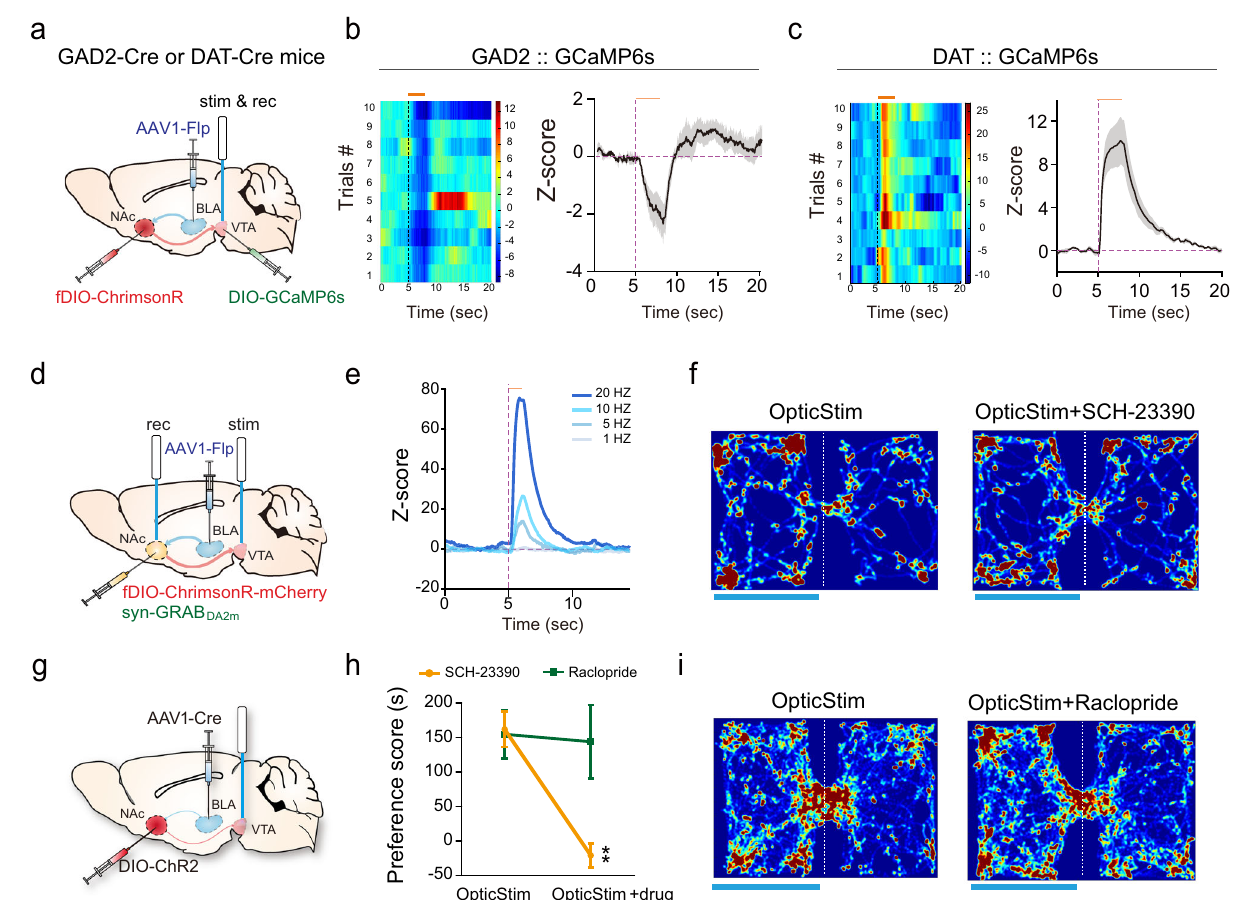
Fig. 5 | NAc BLA neuronsmediate reward by disinhibiting dopaminergic neurons in the VTA. a Schematic showing the experimental design to record Ca 2+ signal from GABAergic or dopaminergic neuronal populations in VTA while delivering optogenetic stimulation to NAc BLA → VTA pathway. b Left: anexampleof a heatmap of calcium activities following optic stimulations in the VTA in a GAD2-Cre mouse. Right:average fi berphotometryresponsetraceofVTAGABAergicneuronselicited by optic stimulation of NAc BLA → VTA pathway ( n =3 mice). The orange horizontal line represents light stimulation (580nm, 20Hz, 3s). Shaded areas in the right panel represent ±s.e.m. c Left: an example of a heatmap of calcium activities fol- lowing optic stimulations in the VTA in a DAT-Cre mouse. Right: Average fi ber photometry response trace of VTA dopaminergic neurons elicited by optic sti- mulation of NAc BLA → VTA pathway ( n =4 mice). The orange horizontal line repre- sents light stimulation (580nm, 20Hz, 3s). Shaded areas in the right panel represent ±s.e.m. d Schematic showing the experimental design to record